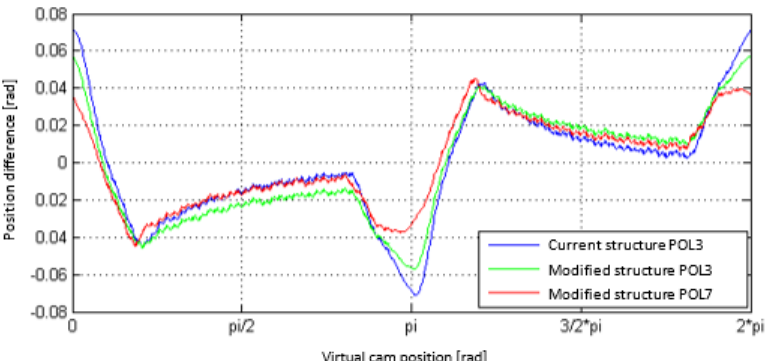
Figure 16. Courses of needle cylinder position deviations, during reverse motion, in all designs at a velocity of 160 min − 1 .